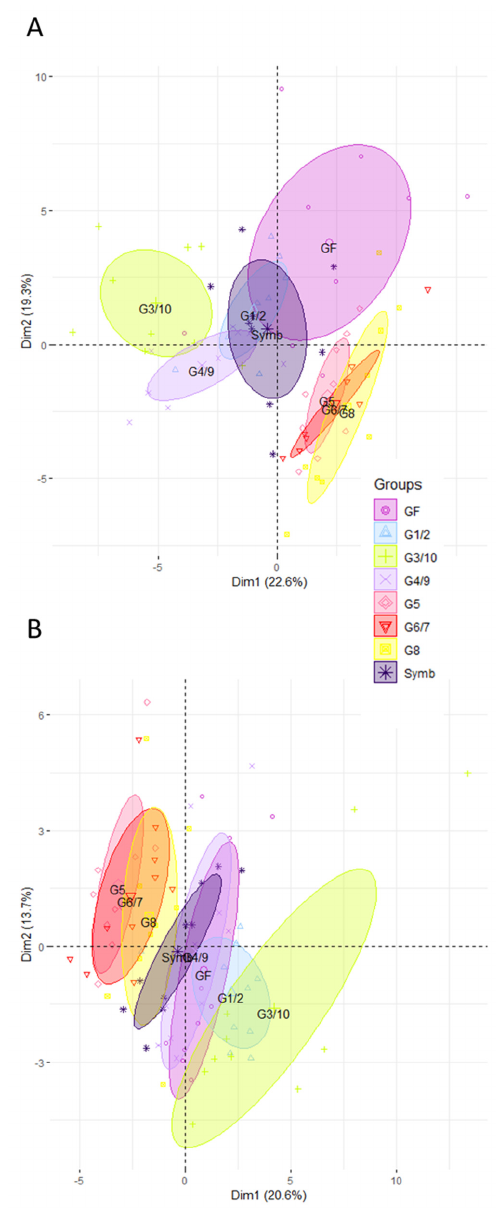
Figure 2. The impact of the Symbioflor2 ® product on intestinal gene expression is not driven by any single genotype. Ileal ( A ) and colonic ( B ) gene expression was analyzed in mice mono-associated with one of the six Symbioflor2 ® genotypes (G1/2, G3/10, G4/9, G5, G6/7, G8), in mice inoculated with the Symbioflor2 ® product containing the six genotypes (Symb), and in GF mice. Rq values that represent the abundance of transcripts relative to GF group were used for PCA analysis after trimming datasets for the least informative genes (see Section 2). In total, 50 genes were retained for PCA in the ileum and 45 in the colon; n = 10 for each group of mice.